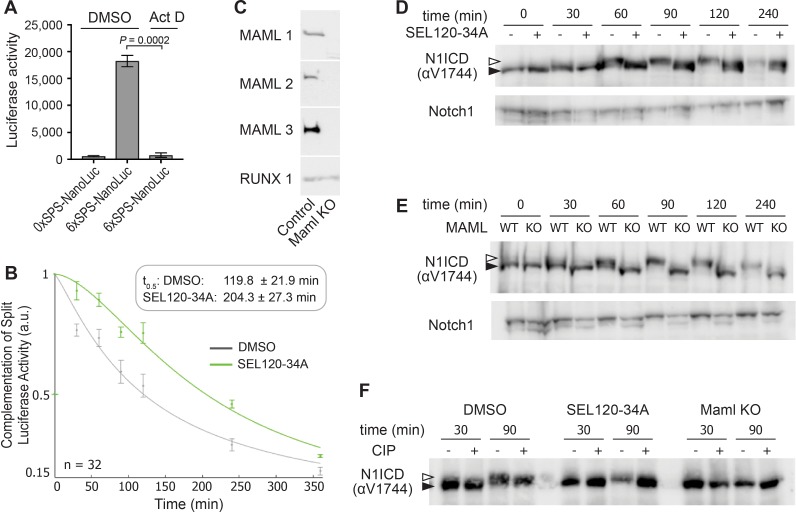
Transcription inhibition doesn't impact NICD mobility.(A) Luciferase activity of 6xSPS-NanoLuc (6S) after Notch activation in mK4 cells treated with either DMSO or Actinomycin D (50 nM). Empty luciferase vector (0xSPS-NanoLuc) was used as control (WT). One-way ANOVA analysis. (B) Rbpj-N1ICD split luciferase assay assessing N1ICD half-life in HEK293T cells treated with DMSO or 1 μM SEL120-34A, a CDK8/CDK19 specific inhibitor. 95% confidence interval noted. (C) Western blot of MAML1-3 in either wild-type or MAML-deficient mK4 cells. RUNX1 is used as a loading control. (D) Western blot of N1ICD and Notch1 in mK4 cells treated with either DMSO or 2 μM SEL120-34A after indicated duration of Notch activation. An antibody that recognizes both the membrane bound and induced Notch1 signal is used as a loading control. Open arrow denotes post-translationally modified NICD and closed arrow denotes un-modified NICD. (E) Western blot of N1ICD and Notch1 after Notch activation in MAML-deficient mK4 cells. Note, N1ICD mobility from MAML-deficient cells did not change over time, consistent with post-translational modifications requiring MAML-mediated DNA binding. An antibody that recognizes both the membrane bound and induced Notch1 signal is used as a loading control. Open arrow denotes post-translationally modified NICD and closed arrow denotes un-modified NICD. (F) Western blot of N1ICD in wild-type mK4 cells treated with either DMSO or SEL120-34A, or MAML-deficient mK4 cells after indicated duration of Notch activation with/without Calf intestinal phosphatase (CIP) treatment.